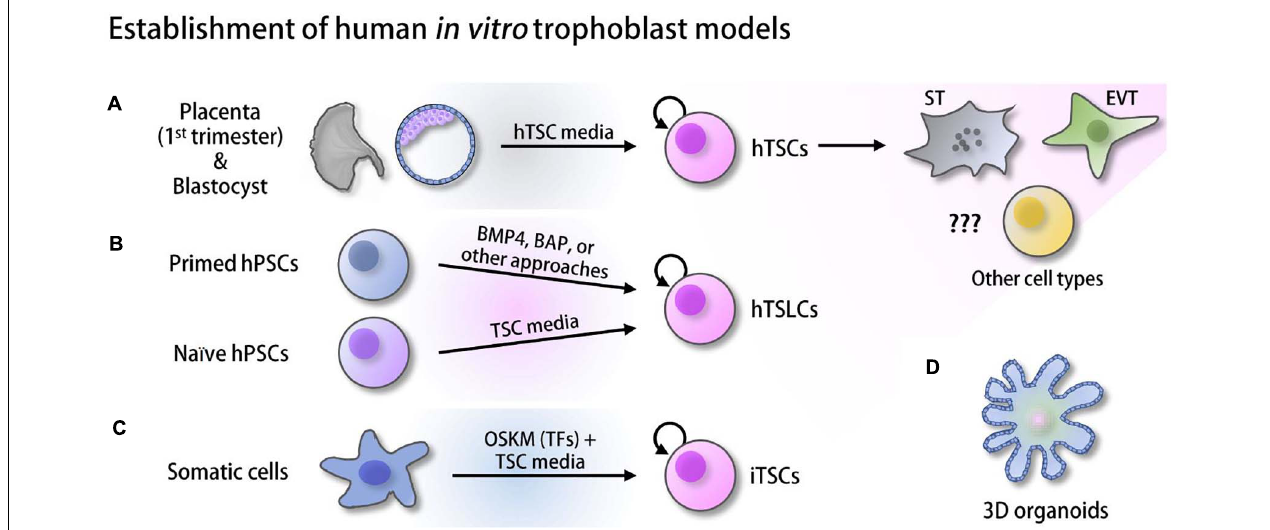
FIGURE 1 | Derivation of human in vitro placenta models. (A) Human trophoblast stem cells (hTSCs) derived from the trophectoderm (TE) of the blastocysts and first-trimester placenta (Okae et al., 2018). (B) Trophoblast stem-like cells (TSLCs) derived from various defined media (Xu et al., 2002; Amita et al., 2013; Li et al., 2013, 2019; Horii et al., 2016; Mischler et al., 2021). (C) Induced trophoblast stem cells (iTSCs) reprogrammed from somatic cells using ectopic expression of OCT4, SOX2, KLF4, and MYC (OSKM) followed by culture in hTSC media (Castel et al., 2020; Liu et al., 2020). (D) 3D organoids established from hTSCs and cytotrophoblast (CT) (Haider et al., 2018; Turco et al., 2018; Saha et al.,